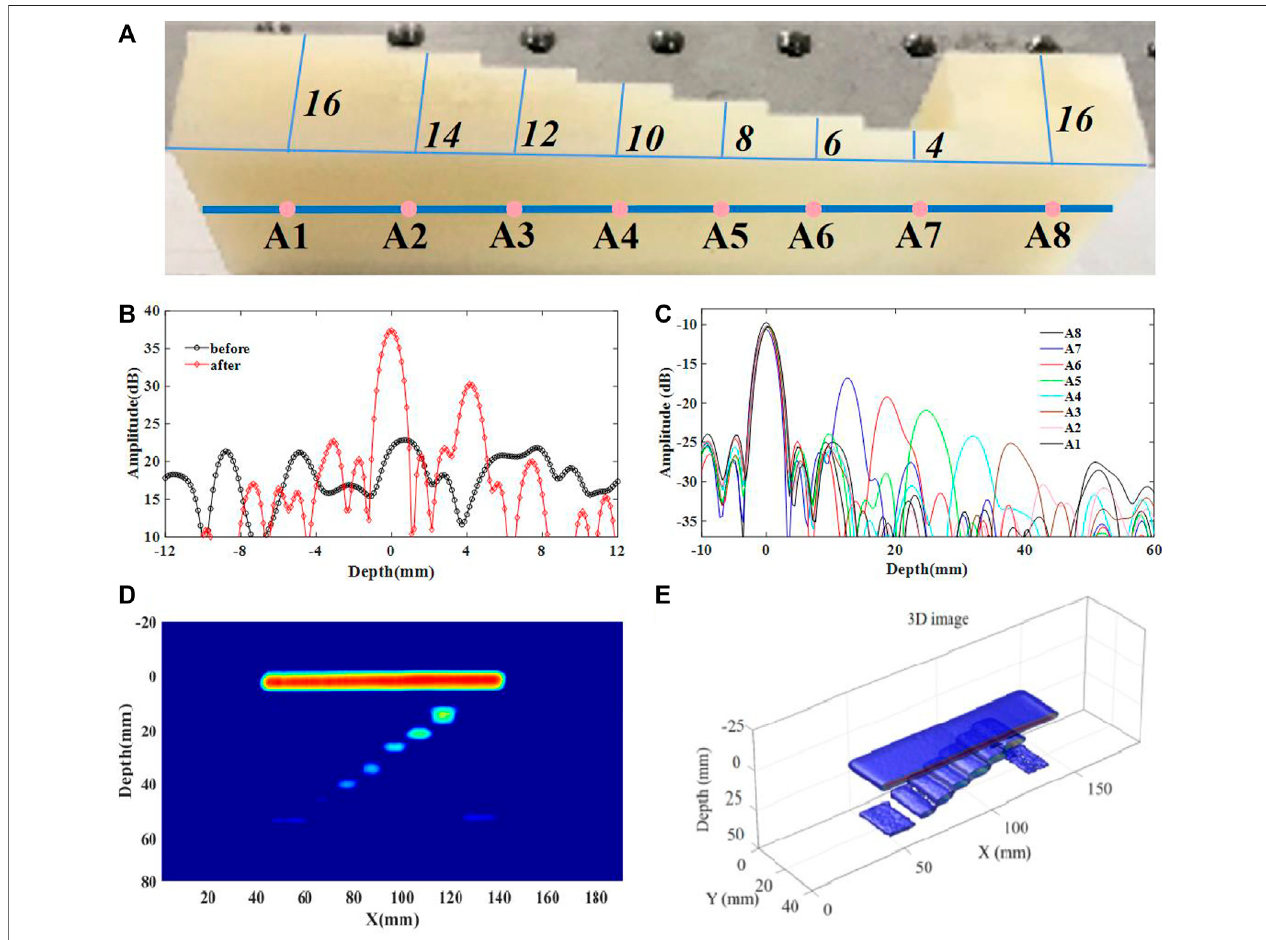
FIGURE 2 | ABS sample: (A) photograph; (B) pro fi le of A7 before and after calibration; (C) pro fi les of A1 – A8; (D) B-scan image; (E) 3D image.